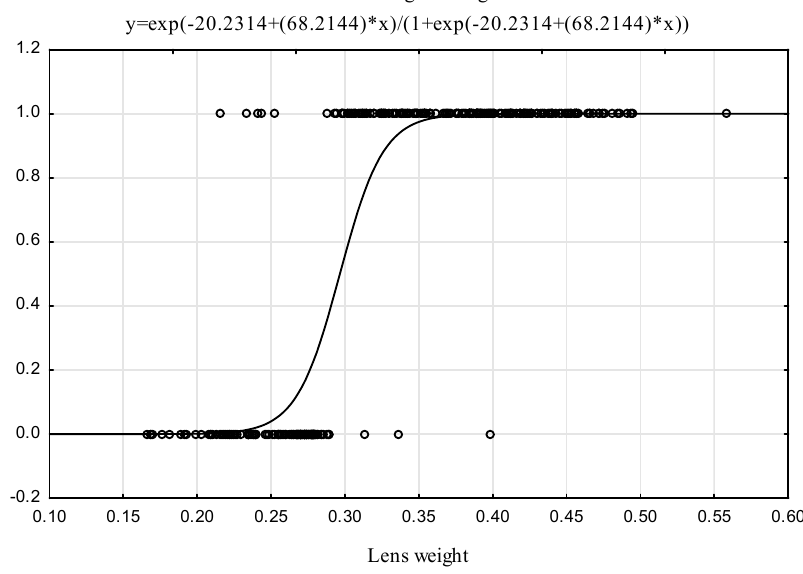
Figure 5. Fitted logit function and observed values (1 = A, 0 = J).